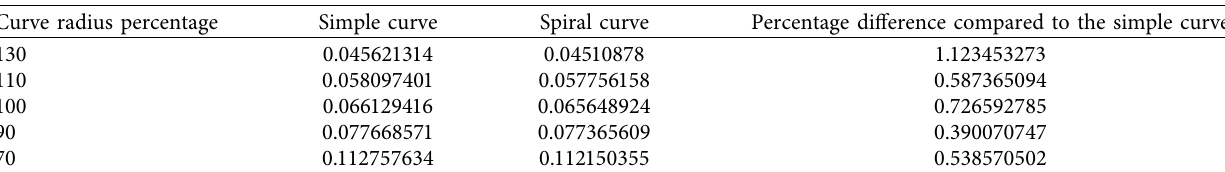
Table 5: Te diference of percentage between the maximum side friction factor in simple and spiral horizontal curves for the truck. Curve radius percentage Simple curve Spiral curve Percentage diference compared to the simple